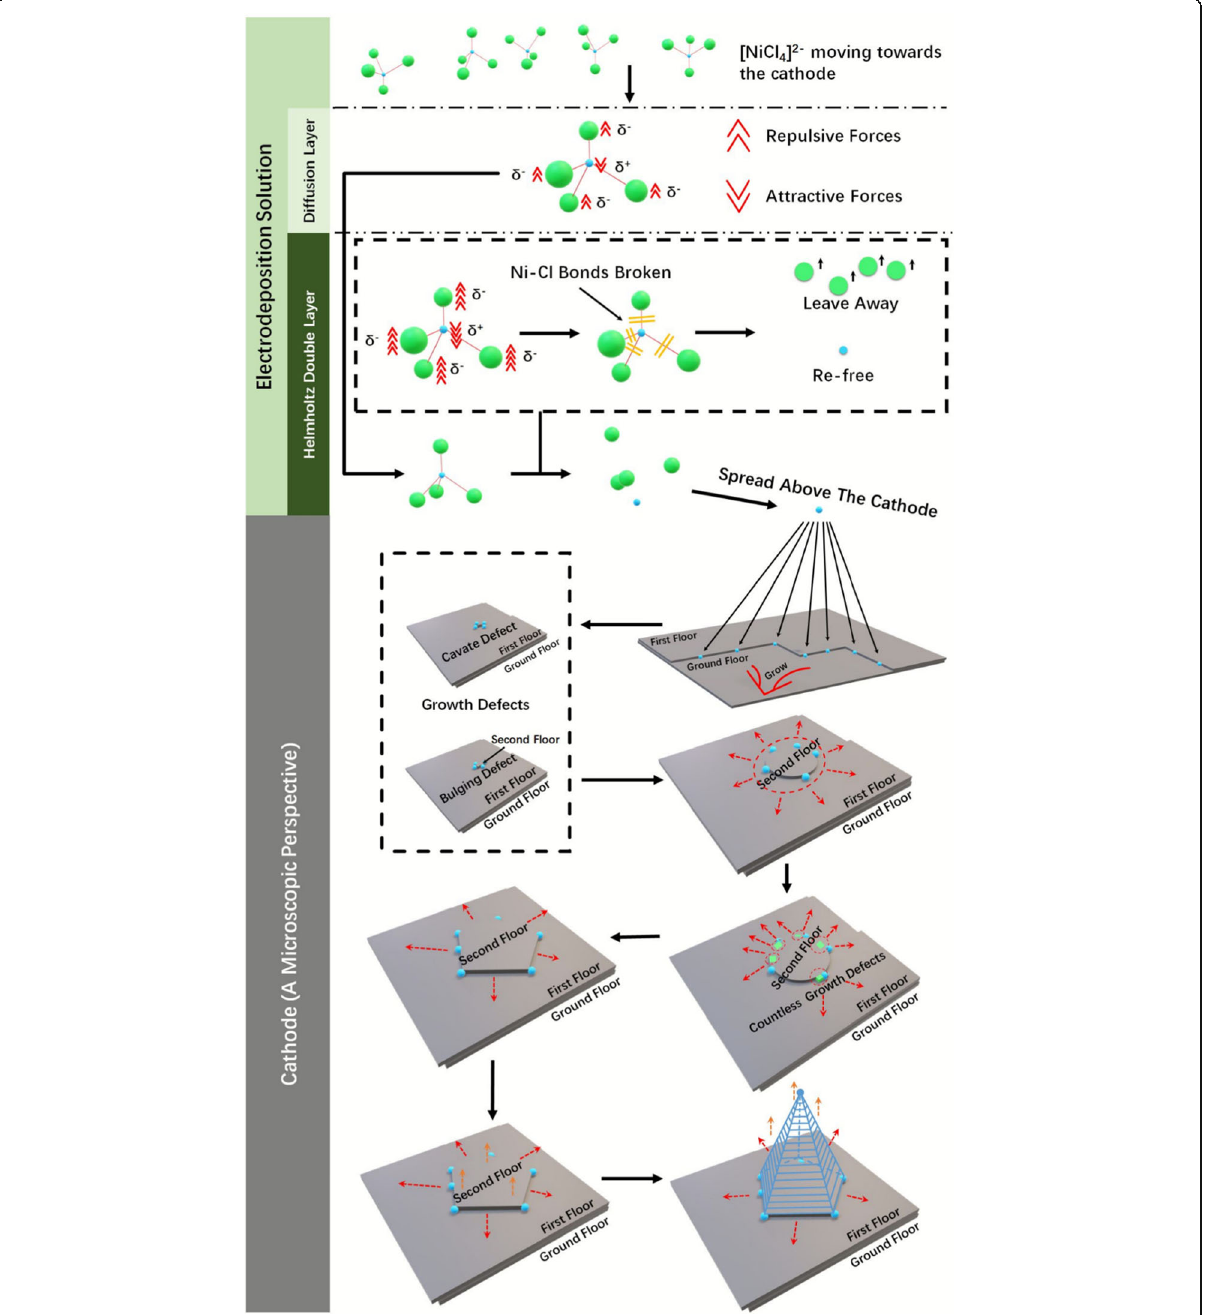
Fig. 3 Multi-dimensional growth mechanism of global order and local disorder: the fracture of [NiCl 4 ] 2 − coordinate covalent bonds, the motion state, and assembly mode of Ni 2+ on the